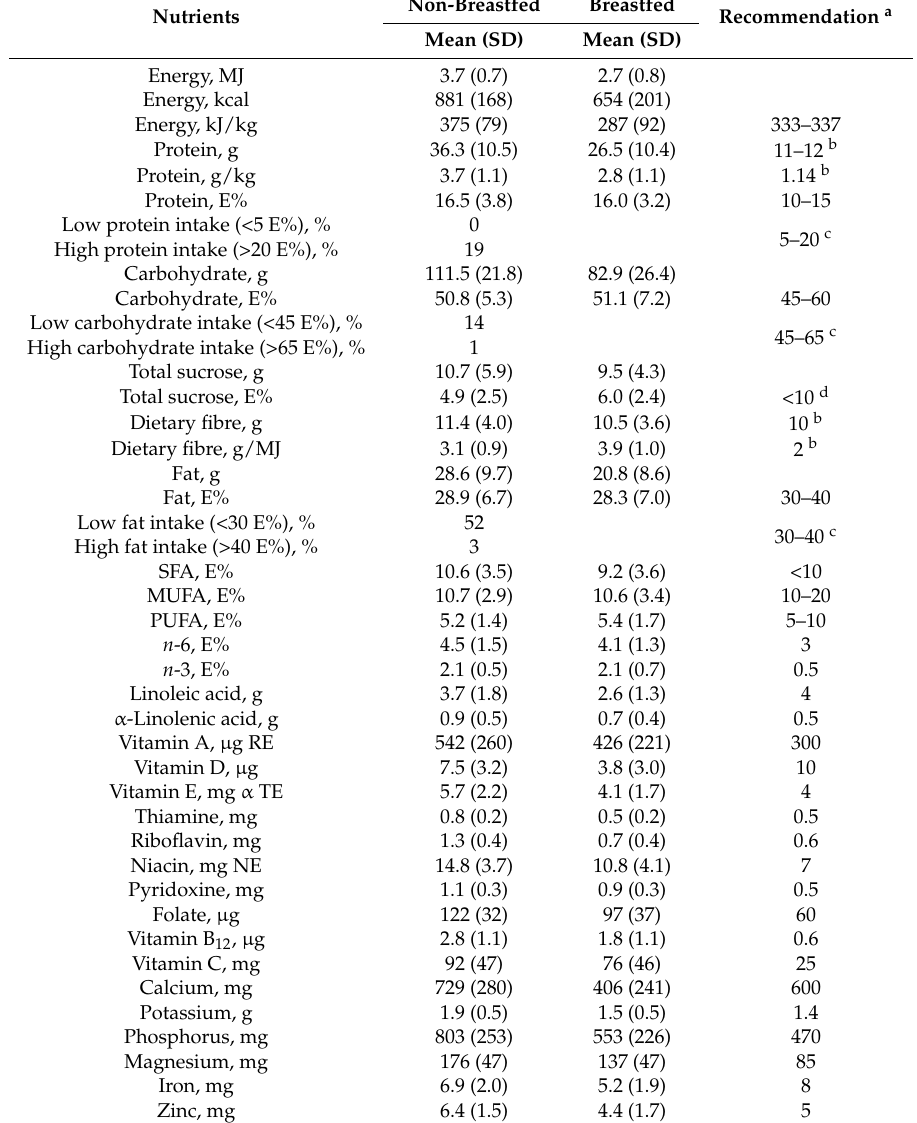
Table 3. Mean daily nutrient intake from food (unless stated otherwise) in non-breastfed ( n = 476) and breastfed ( n = 263) 1-year-old